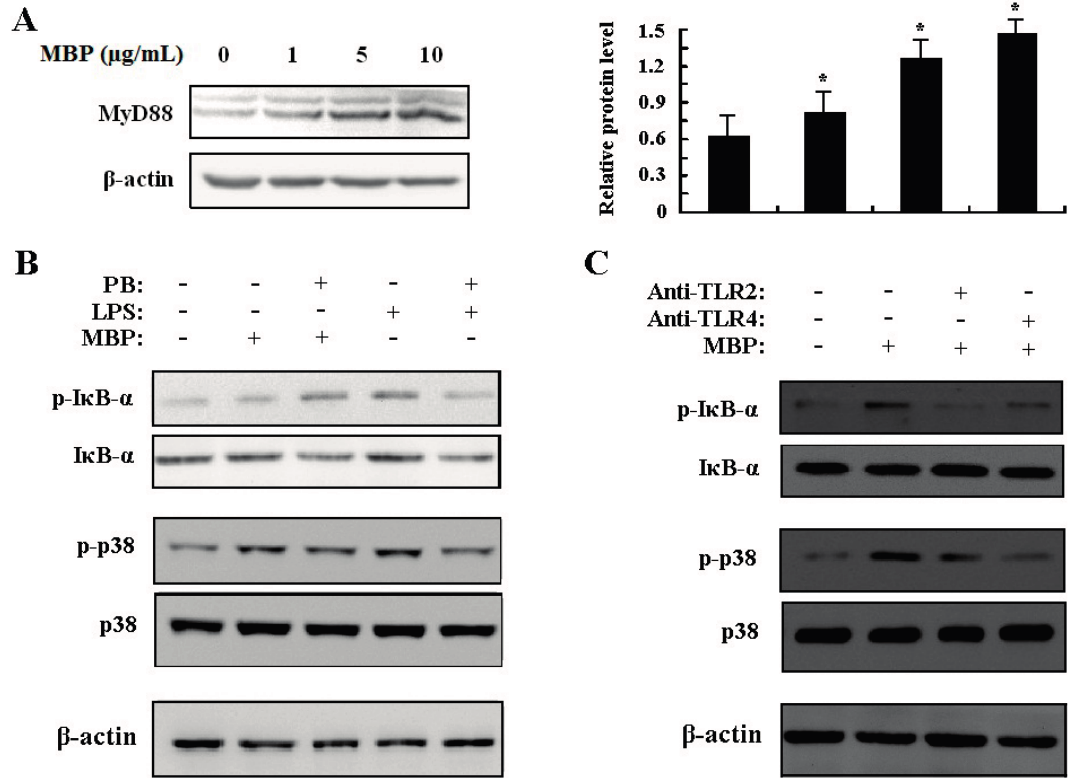
Figure 5. Effects of MBP on activation of NF- κ B and p38 MAPK via TLR2 and TLR4. ( A ) RAW264.7 cells were treated with MBP (1, 5, 10 μ g/mL) for 6 h. MyD88 expression was determined by Western blotting using whole cell lysates. MyD88 protein levels relative to the endogenous control β -actin were quantified and presented in bar graph. * p < 0.05 compared with the untreated control; ( B ) RAW264.7 cells were treated